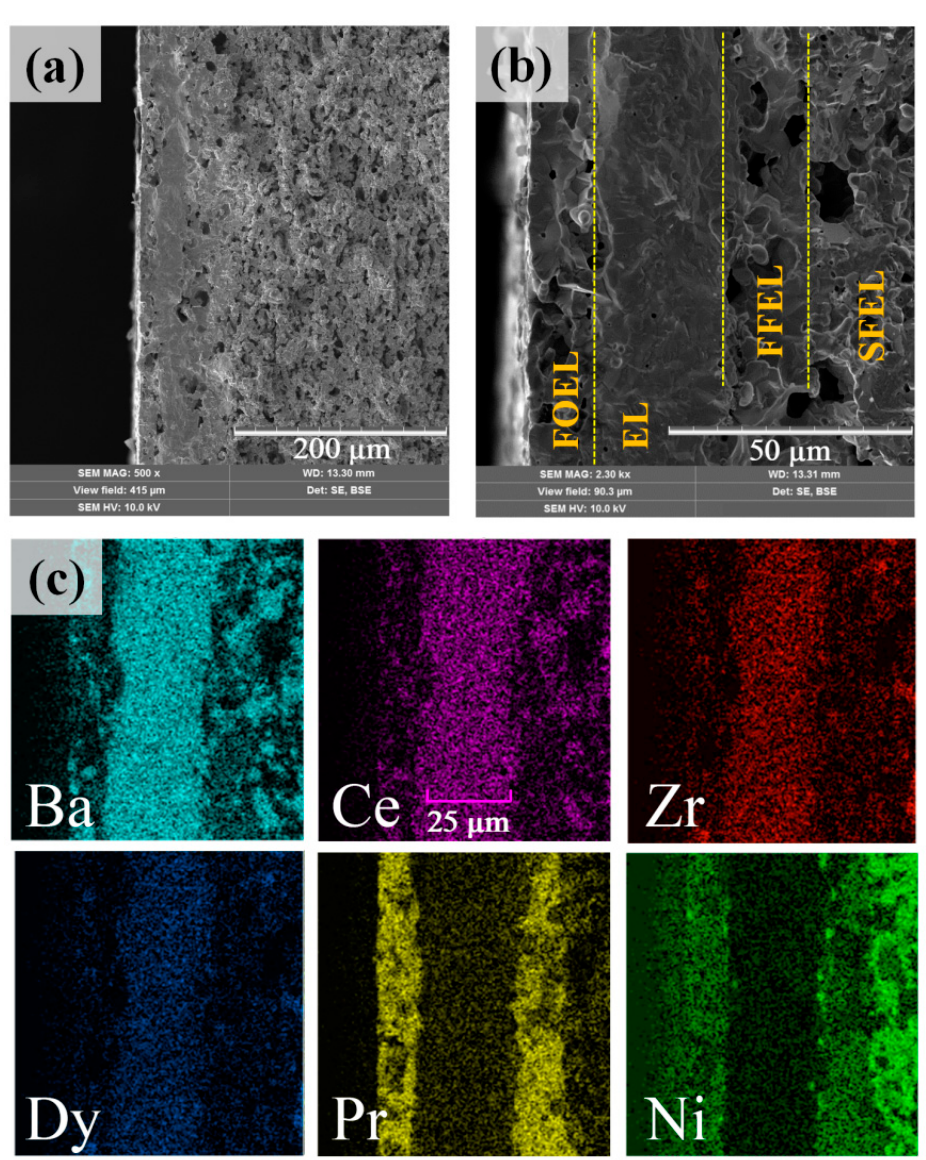
Figure 3. Cross-section images of the fabricated rPCC at different magnification ( a , b ) and maps of the elements distribution ( c ).